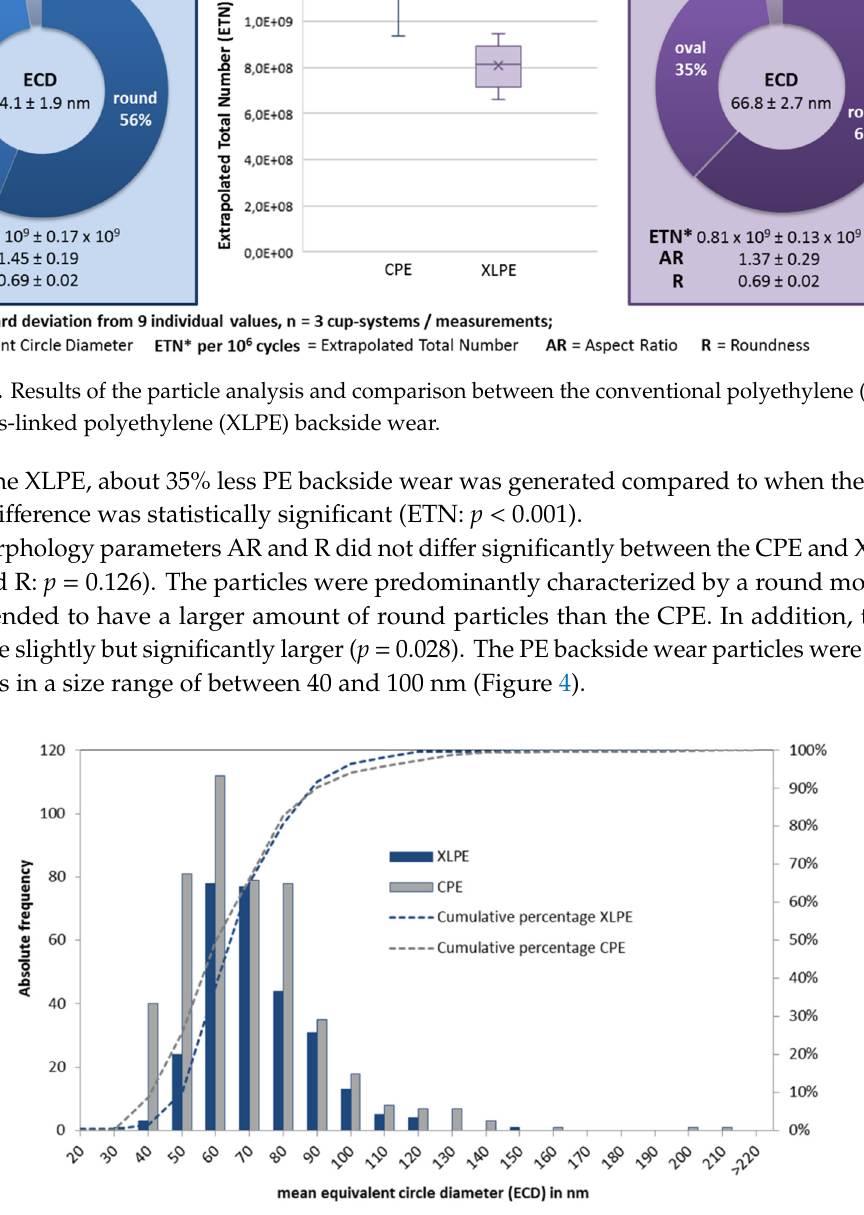
Figure 2. Filter images of the analyzed backside PE wear particles.